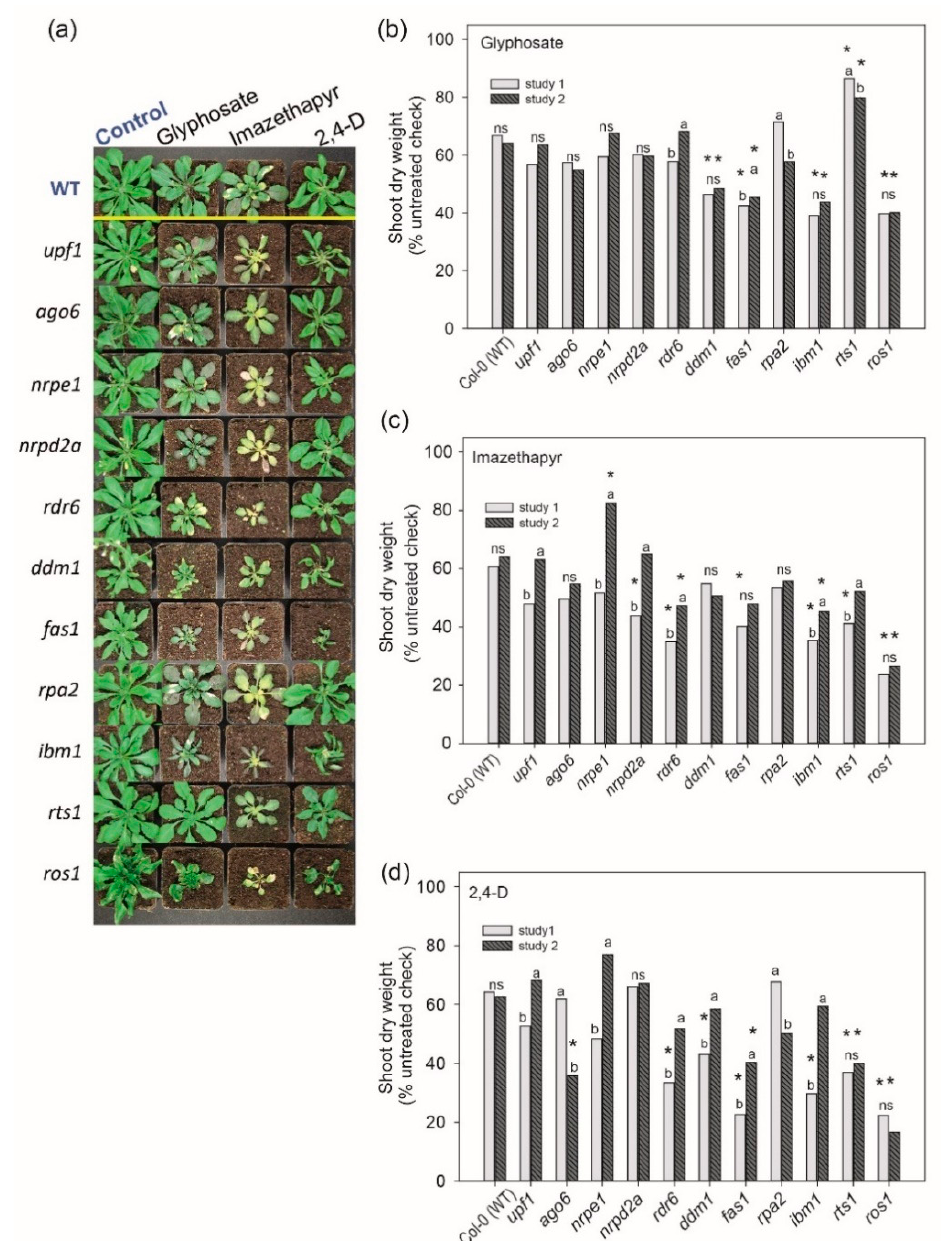
Figure 2. ( a ) Effect of sublethal doses of glyphosate, imazethapyr and 2,4-D on Arabidopsis thaliana wild type (WT) and selected chromatin mutants 10 days after treatment (DAT). ( b – d ) Shoot dry weight from treated plants compared to non-treated plants (% untreated check) after ( b ) glyphosate, ( c ) imazethapyr and ( d ) 2,4-D treatment. The mean of each study (1 and 2) was composed by three biological replicates, studies 1 and 2 followed by different letter differ significantly by Tukey’s test ( p ≤ 0.05); ns = nonsignificant. Treated mutants followed by asterisk differ significantly from treated WT, according to Tukey’s test ( p ≤ 0.05); * compared to WT.